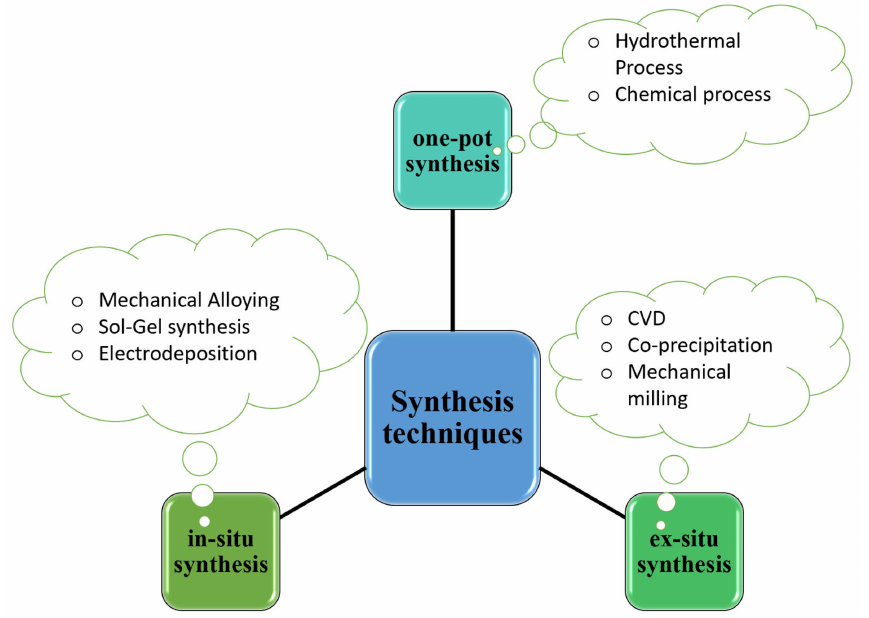
Figure 9. Synthesis techniques of chalcogenide-based